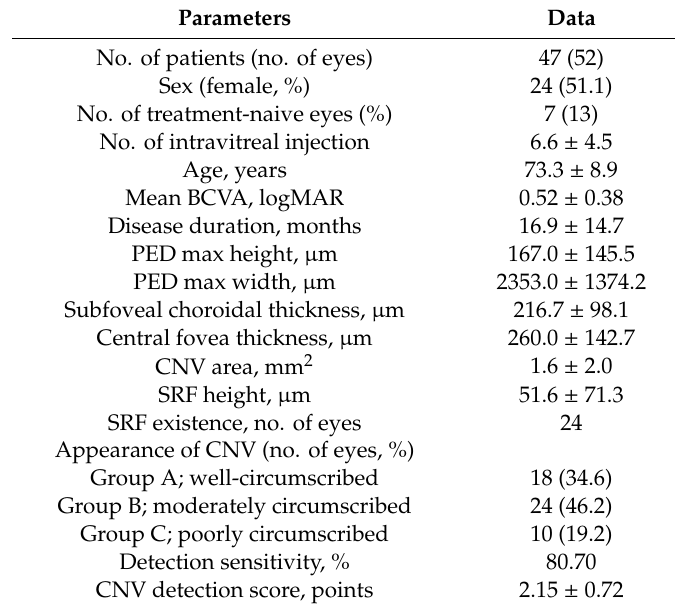
Table 1. Patient demographics and parameters of optical coherence tomography (OCT) and OCT angiography in patients with neovascular age-related macular degeneration. Parameters